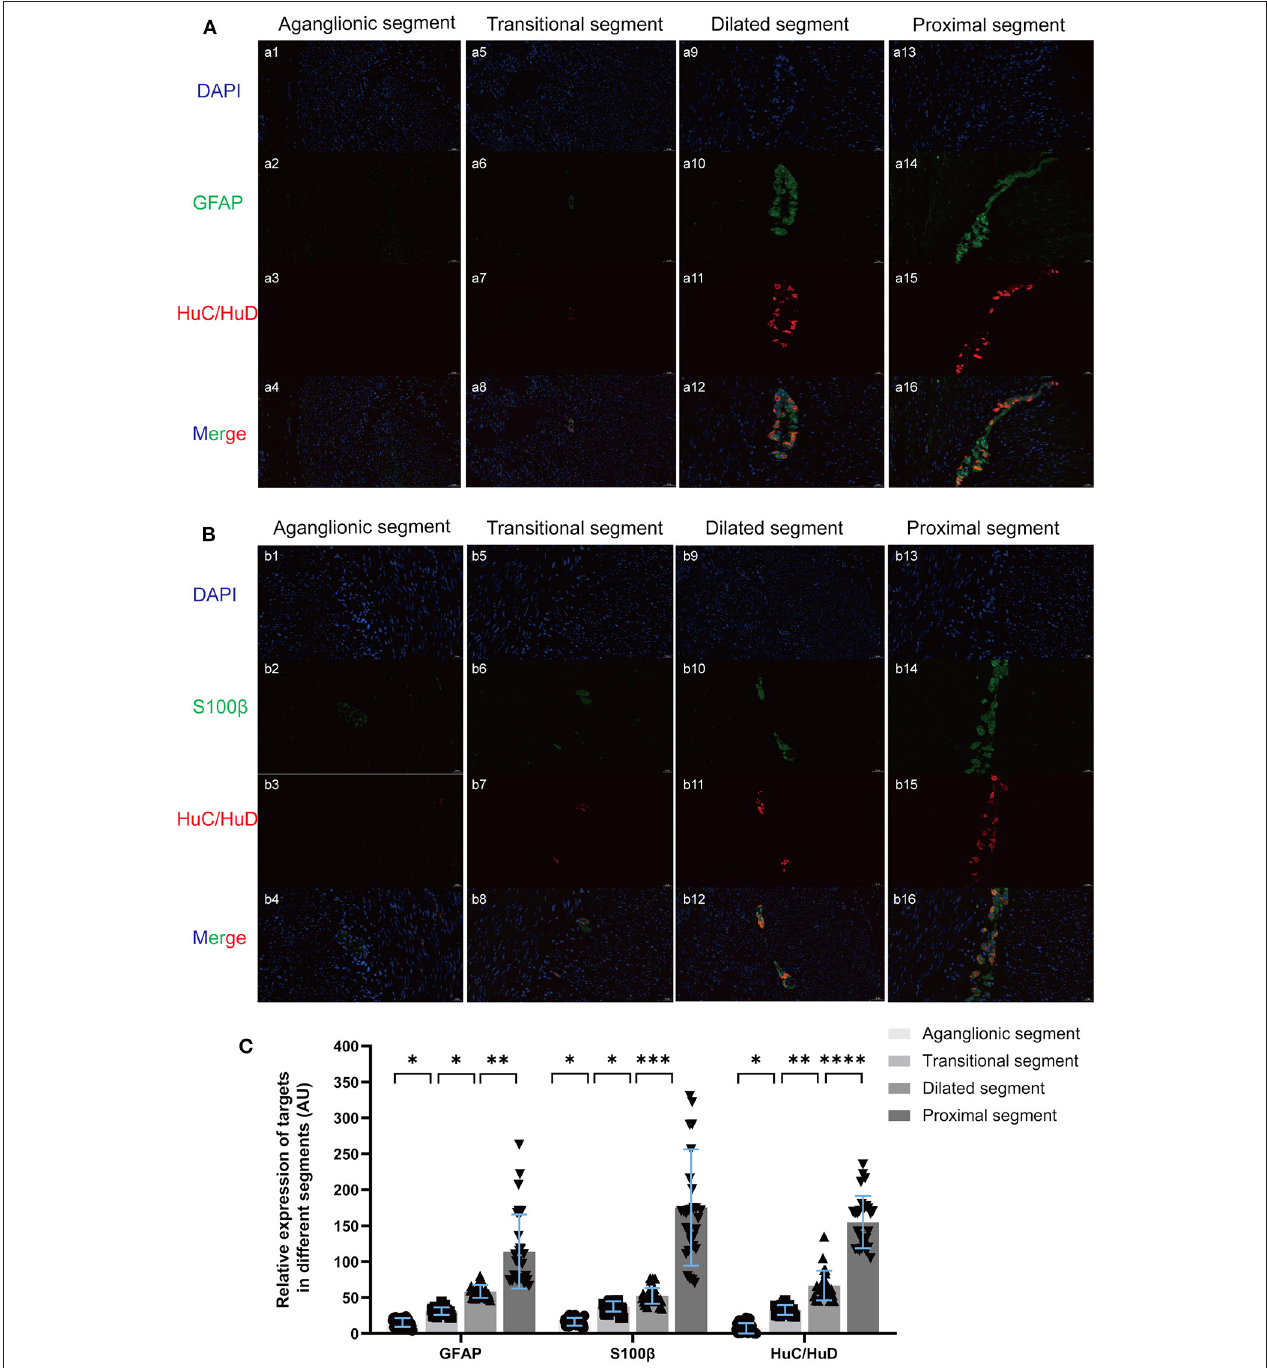
FIGURE 2 | Double-label IF of GFAP ( A green), S100 β ( B green), and HuC/HuD (red) revealed a corresponding relationship in the location of EGCs and ENCs in myenteric ganglions, and the average fluorescence intensity of the unit area was quantified (C) . There was no obvious positive staining of targets in the aganglionic segment (a1-a4, b1-b4). The shapes of ganglions in the muscles in transitional and dilated segments were irregular and hypoplasic (a5-a12, b5-b12), while the ganglion in proximal segments was more intact and the EGCs were located around the ENCs (a13-a16, b13-b16). (Scale bar: 20 µ m ns, p > 0.05; * p < 0.05; ** p < 0.01; *** p < 0.001; **** p < 0.0001).